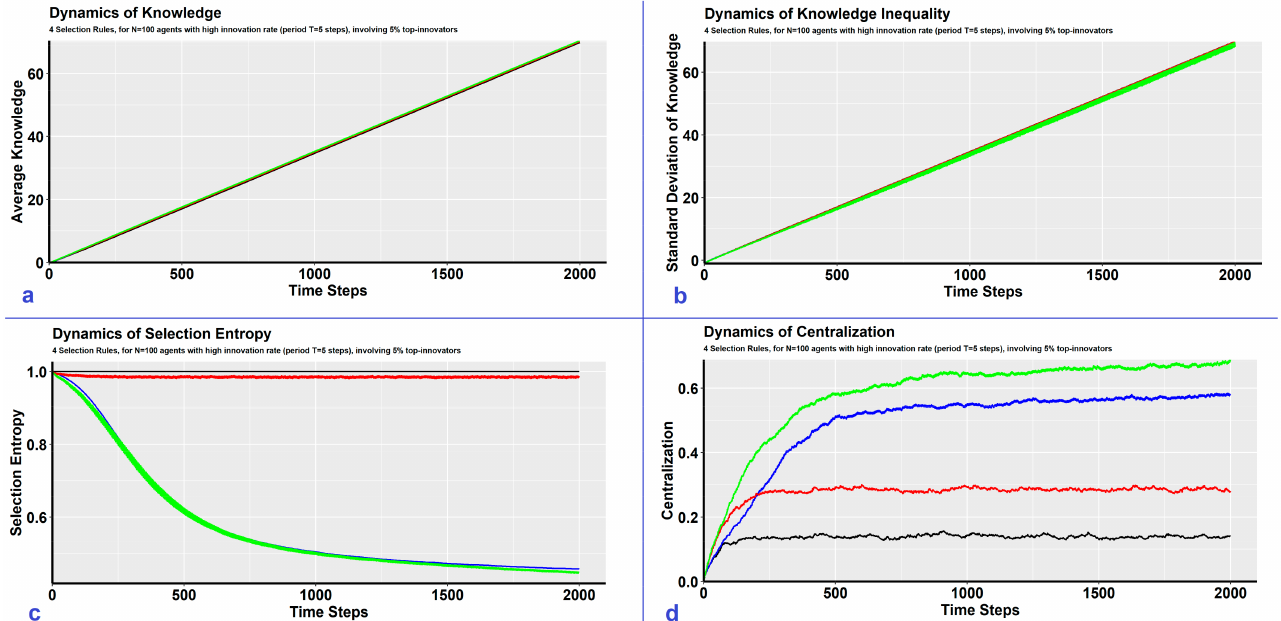
Figure 2. Simulations for the 4 different probabilistic selection rules: (1) random s = 𝓇 (black), (2) knowledge s = 𝓀 (red), (3) weight s = 𝓌 (blue), (4) knowledge‑weight s = 𝓌𝓀 (green). Results are illustrated for: ( a ) the average knowledge (Definition 8, up left), ( b ) the standard deviation of knowledge (Definition 9, up right), ( c ) the selection entropy (Definition 10, down left), ( d ) the centralization (Definition 13, down right). The y axis for the average knowledge ( a , up left) and the standard deviation of knowledge ( b , up right) is in log‑10 scale, indicating the exponential increase of knowledge dynamics. Results are illustrated for 𝑁 = 100 agents with high innovation rate (period 𝑇 = 5 steps), involving 5%